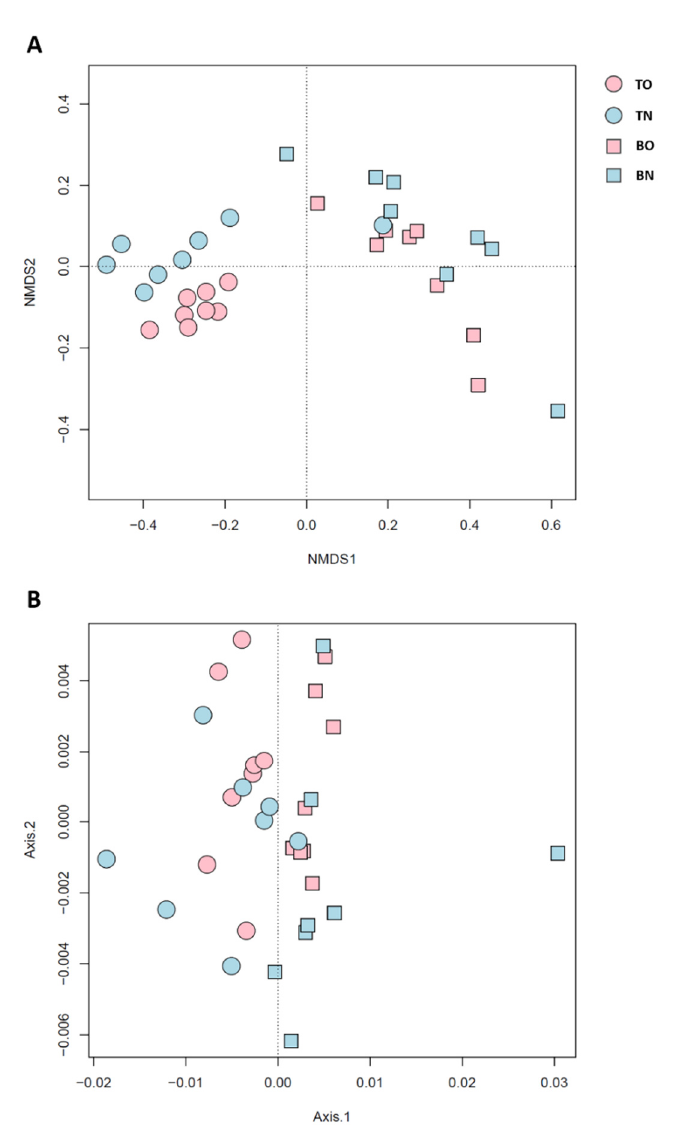
Figure 5. ( A ) Phylogenetic β -diversity based on keystone species only shown by NMDS; ( B ) keystone species based on phylogenetic β -diversity in the PCoA. Each point represents one